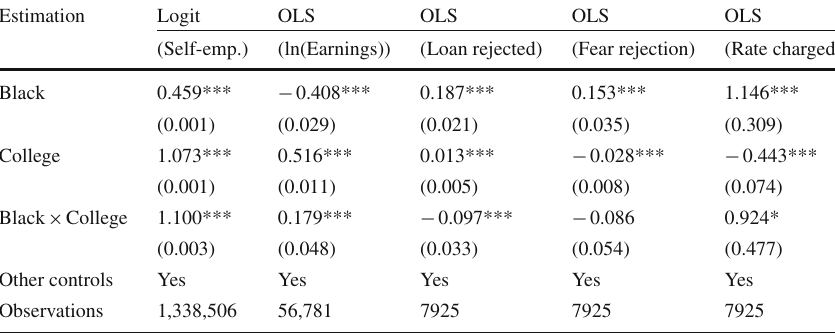
Table 1 Features of the market for self-employment—effect of social identity and ability. Source : ACS 2006 for column (1)–(2), NSSBF 1998, 2003 for column (3)–(5)